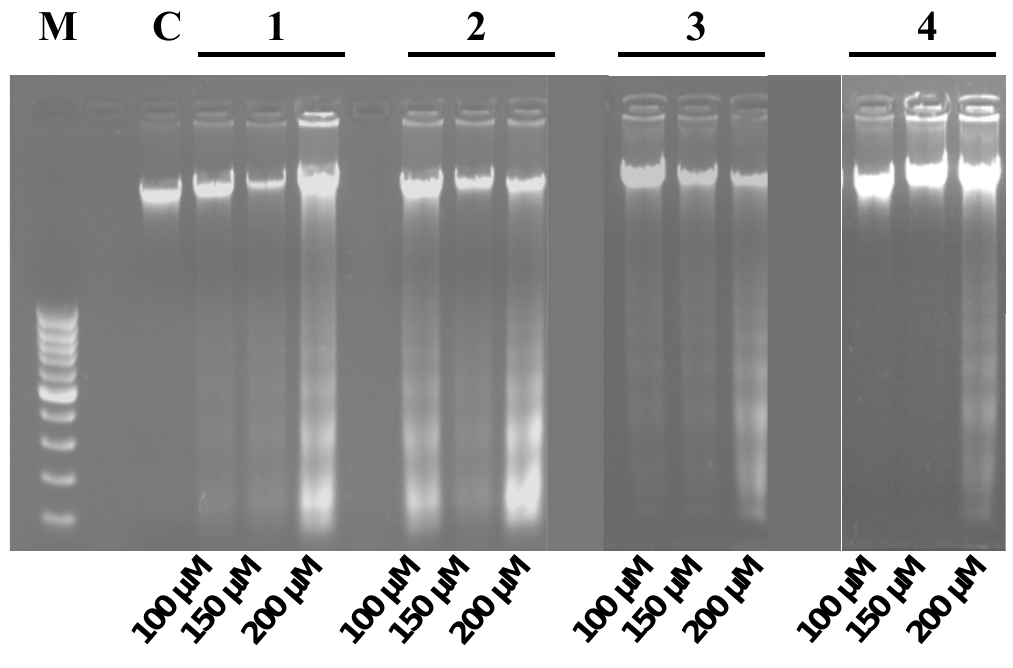
Figure 3. Effects of chalcones on the DNA fragmentation pattern analysis by agarose gel electrophoresis of HepG2 cells after 24 h incubation.